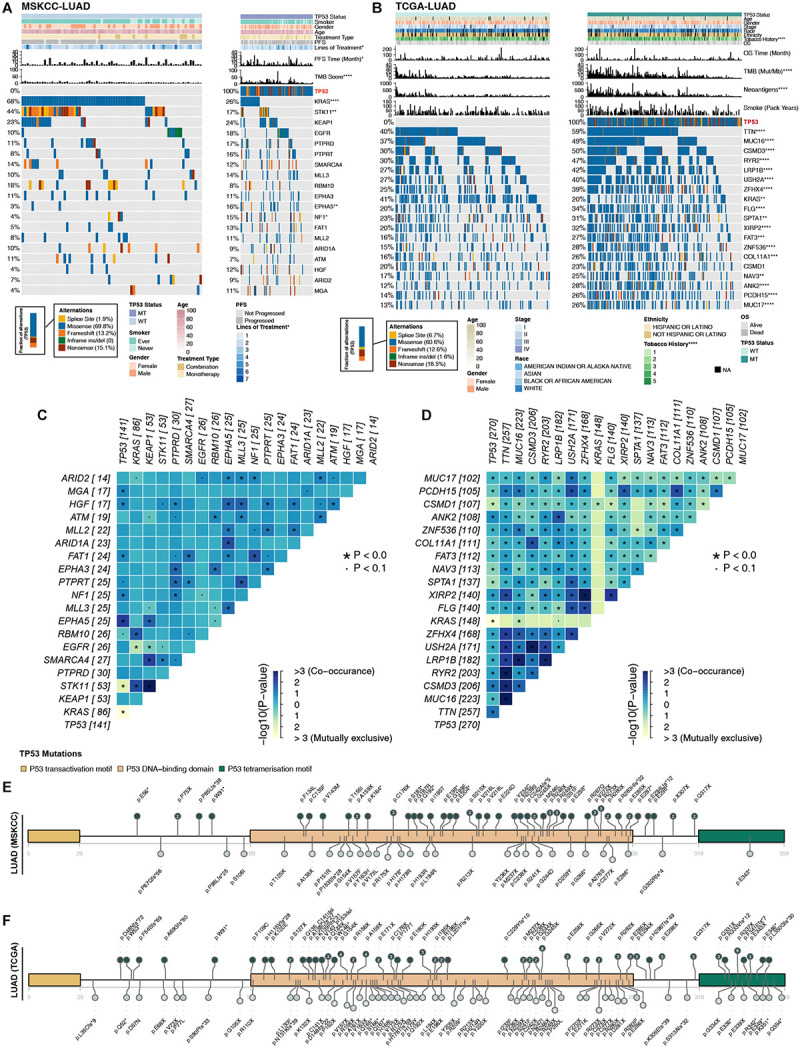
Comparison of related genetic characteristics and clinical data between TP53-mutated and TP53-wild-type LUAD. Panoramic views of TP53-wild-type and TP53-mutated patients in the MSKCC-LUAD cohort (A), the TCGA-LUAD cohort (B), including comparisons of genetic characteristics and clinical data. PFS, progression-free survival; OS, overall survival. Heatmap showing mutually exclusive and co-occurring mutations in the top 20 mutated genes in the MSKCC-LUAD cohort (C) and TCGA-LUAD cohort (D). The mutation site of TCGA-TP53 in the MSKCC-LUAD cohort (E) and the TCGA-LUAD cohort (F). Different colors correspond to different types of functions; the height of the circle represents the number of mutations. ****P < 0.0001, ***P < 0.001, **P < 0.01, *P < 0.05.